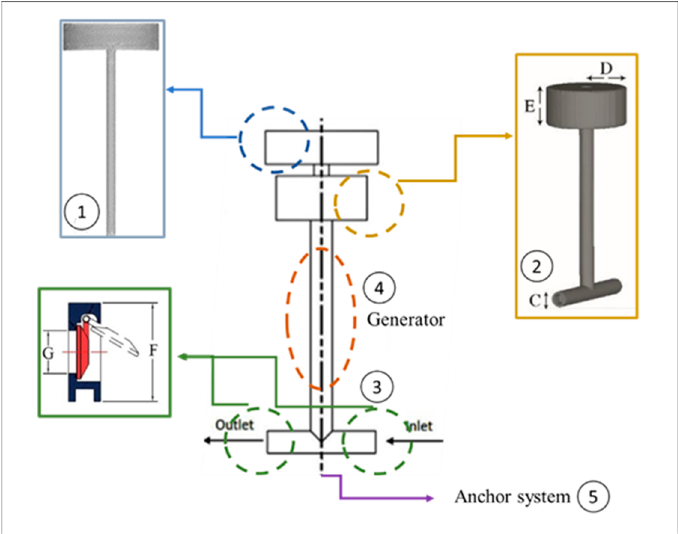
Figure 3. Different parts of a Searaser; (1) buoy; (2) chamber; (3) valves; (4) generator; (5) anchor system.